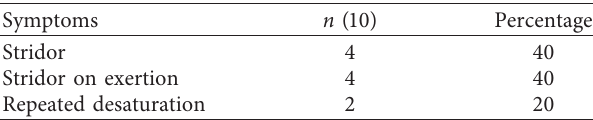
Table 1: Presenting